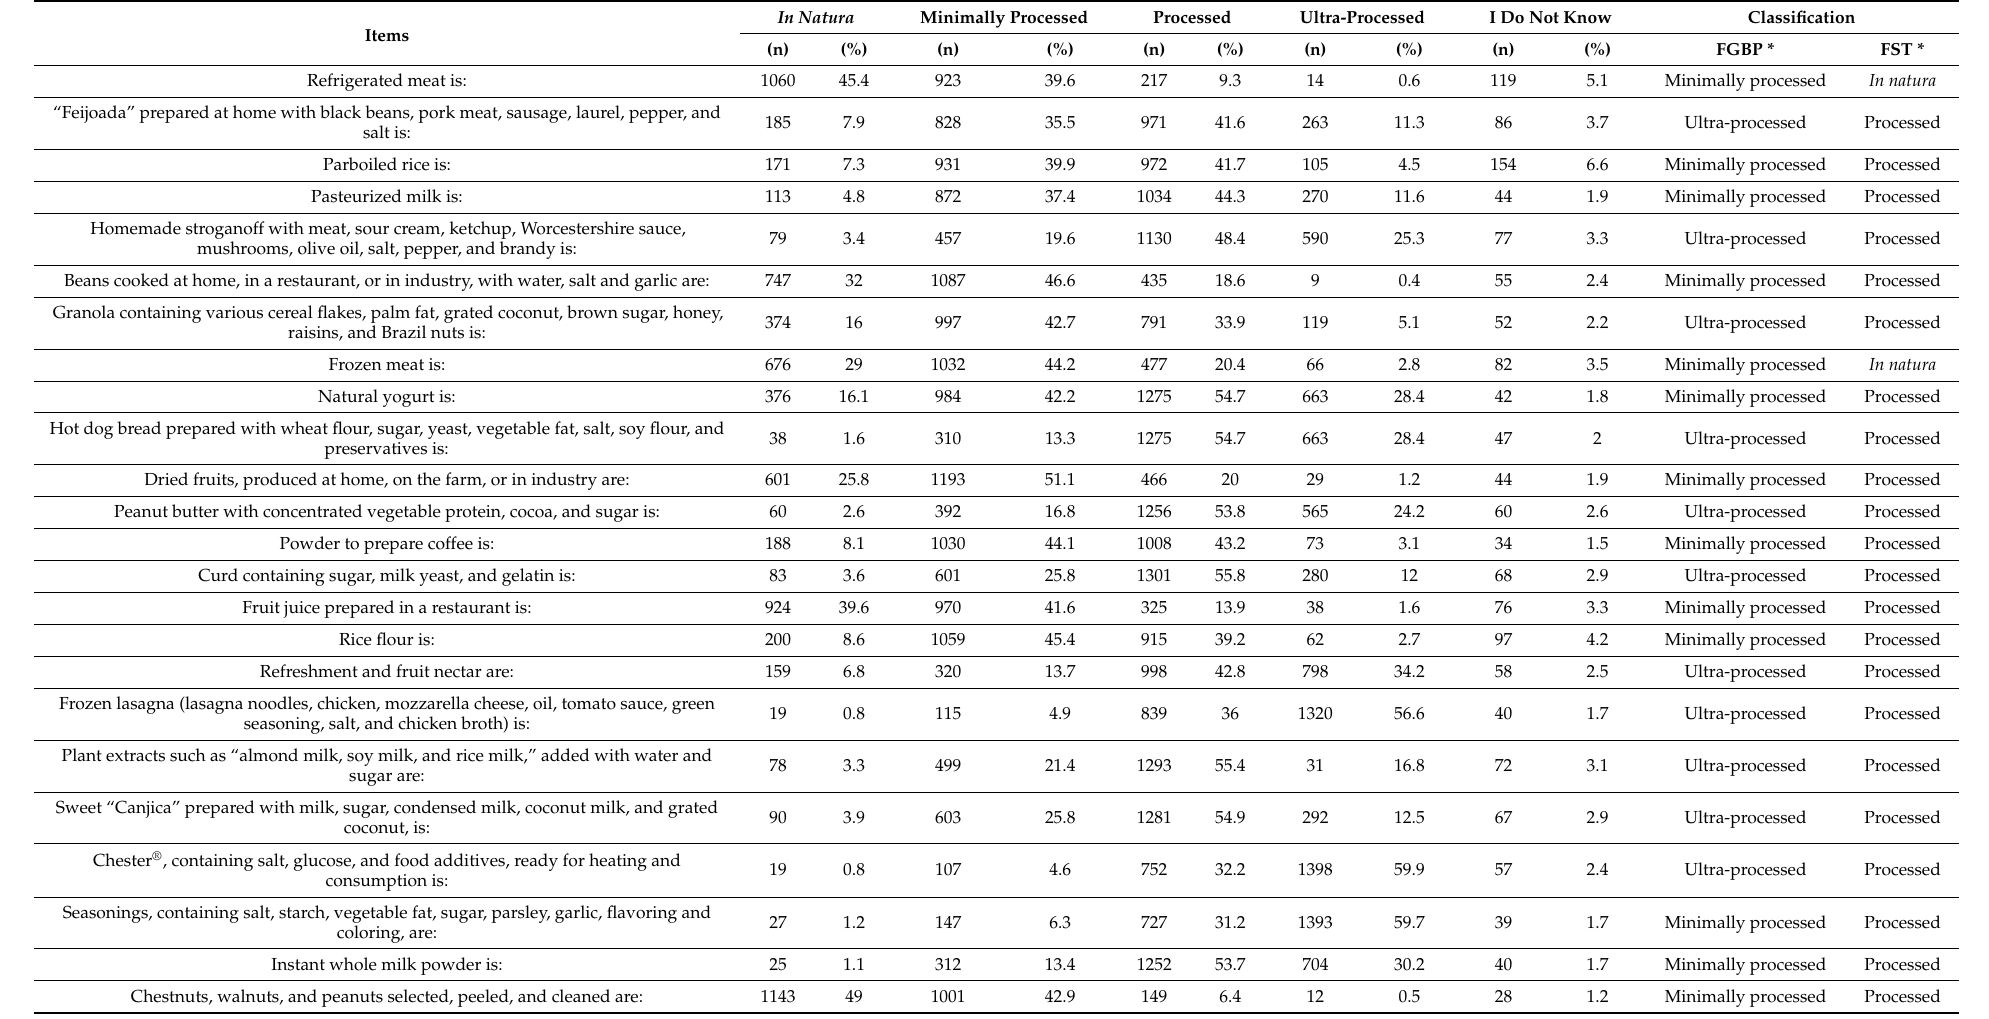
Table 2. Number and frequency of respondents for the general classification of